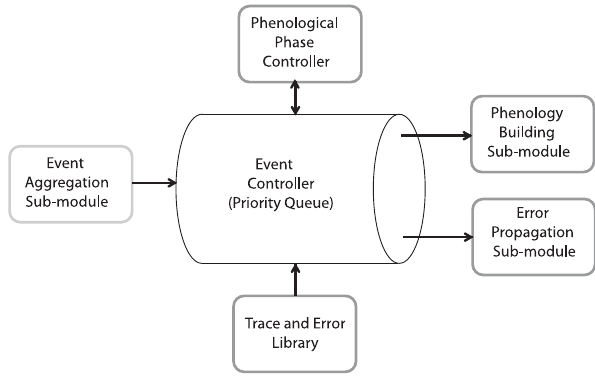
Fig. B2. Data communication scheme for Event Controller that im- plements logistical core of the EDPM.